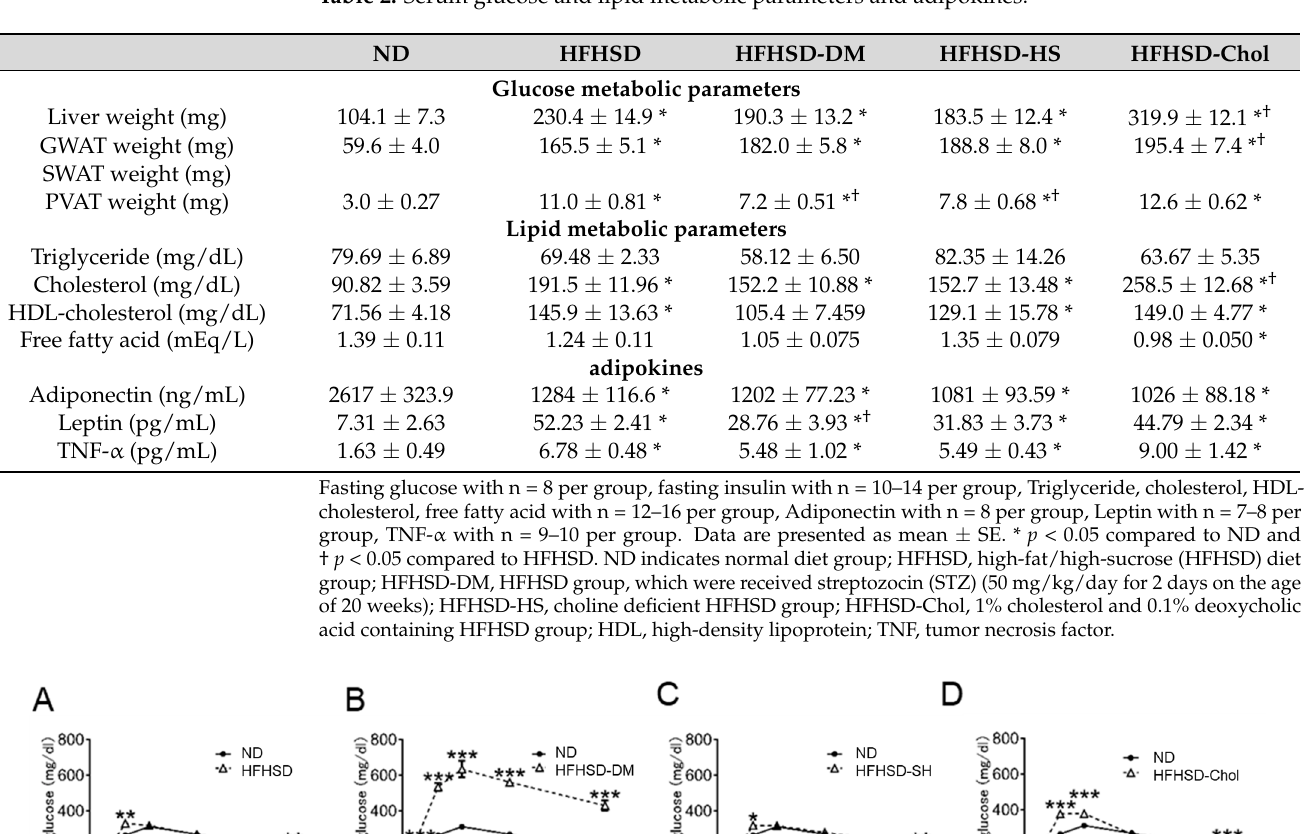
Table 2. Serum glucose and lipid metabolic parameters and adipokines.